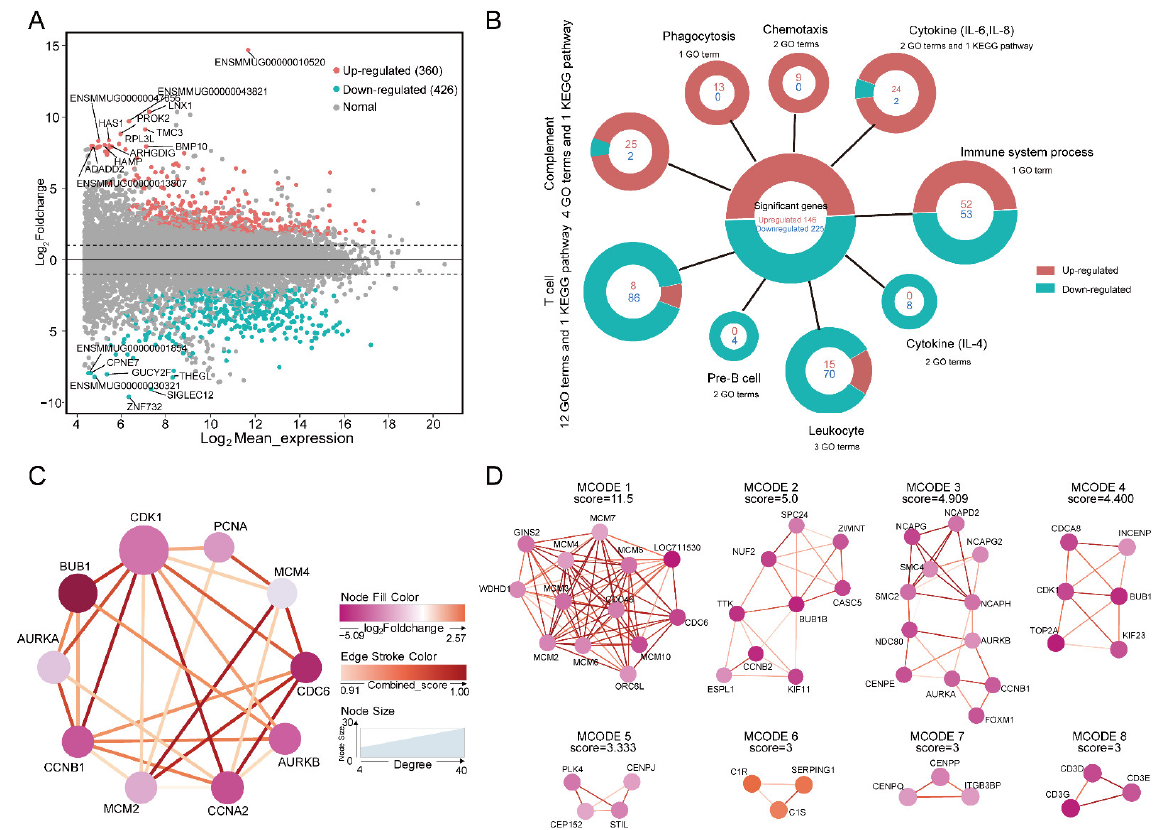
Figure 3. Differentially expressed genes (DEGs) in the adult group compared with the young group. ( A ) MA plot showing the distribution of the log 2 mean expression plotted against the log 2 fold change for each gene. Upregulated and downregulated genes are depicted by red and blue dots, respectively (n = 2 per group). Grey dots indicate non-differentially expressed genes. The top 20 most differentially expressed genes are labeled. The numbers of up- and downregulated DEGs were 360 and 426, respectively. ( B ) GO terms and KEGG pathways enrichment analysis were largely related to immunity in DEGs. A circular diagram showing the upregulated and downregulated pathway terms related to immunity (brown, upregulated; green, downregulated) in DEGs (FDR < 0.05). ( C ) PPI analysis of 786 DEGs in the adult group compared with the young group. The network of ten hub genes with 12 algorithms using the cytoHubba plugin of Cytoscape v3.7.1. The color gradation of the node is representative of the log 2 fold change. The color of the edge stroke represents the combined sore between two genes. The node size represents the degree level of hub genes. ( D ) The networks of eight MCODE models with a multi-protein complexes clustering algorithm using the Molecular Complex Detection (MCODE) plugin of Cytoscape v3.7.1. The color gradation of the node is representative of the log 2 fold change. The color of the edge stroke represents the combined sore between two genes. The node size has no meaning.